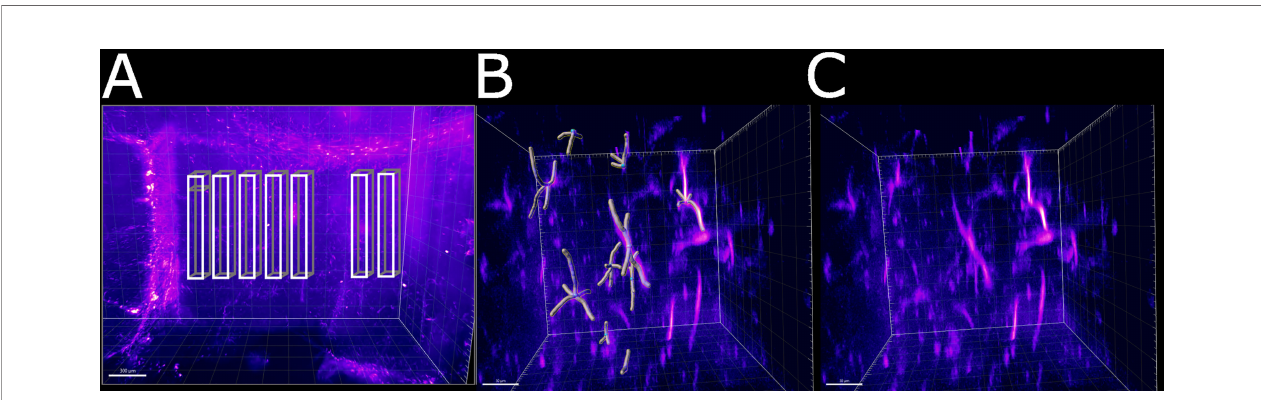
FIGURE 6 | Schematic of the areas in which the astrocytes were tracked. (A) Area of the right ventricle of the infected specimen in which the astrocytes were manually tracked. Each box was divided in 5 sub-boxes of 200 µm 3 for ease of tracking. Example of the sub-region in which 10 astrocytes were manually tracked (B) with and (C) without the Imaris fi lament object. The scale bar is respectively (A) 300 µm and (B, C)